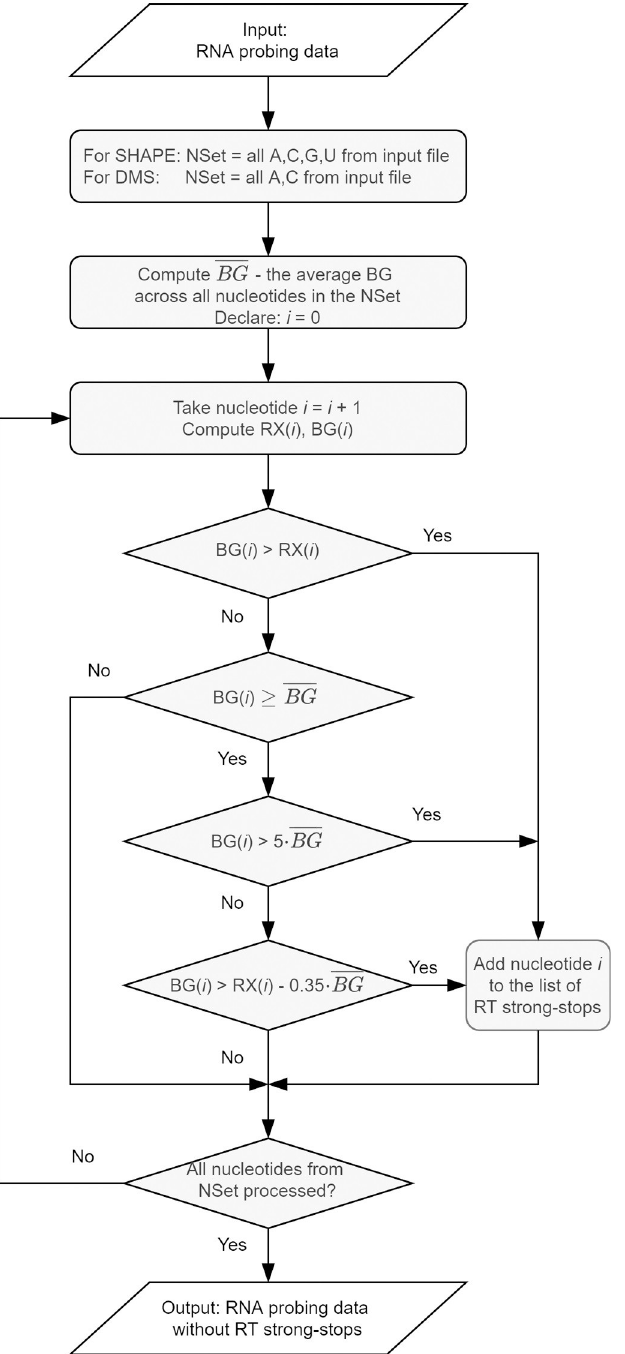
Fig 2. Scheme of the RNAthor algorithm for unreliable data